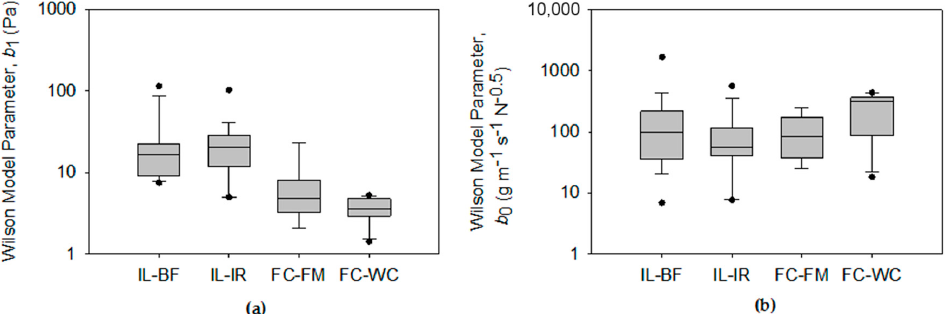
Figure 4. Variation of Wilson model parameters measure using JETs along Barren Fork Creek (IL-BF), Illinois River (IL-IR), Fivemile Creek (FC-FM) and Willow Creek (FC-WC): ( a ) b 0 ; and ( b ) b 1 .